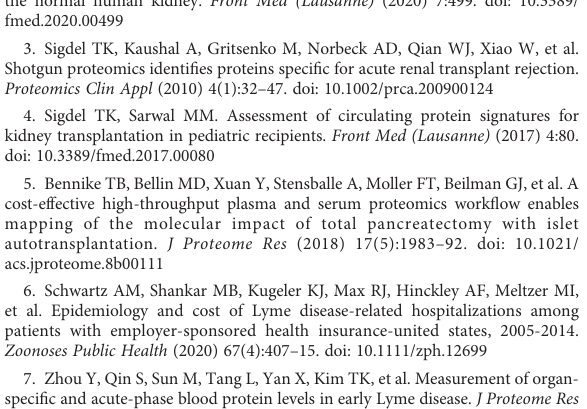
SUPPLEMENTARY FIGURE 1 Proteome comparison in localized and disseminated LD participants over time. (A) Analysis of differentially expressed proteins (DEPs) and immunoglobulins (DEIgs) between the localized (orange) and the disseminated (blue) LD samples at M0 (A) , M1 (B) and M3 (C) time points. For each cluster, the protein names were exported into the STRING interaction network. The white dotted lines represent the median of the Log2 difference of all proteins in the cluster. The proteins highlighted in red are involved in the acute phase response, in blue the proteins involved in the complement cascade, in green the proteins involved in the negative regulation of proteolysis, in yellow the proteins involved in the protein activation cascade, and in pink the proteins involved in the blood coagulation. (B-D) . Longitudinal analysis using the STEM program for clustering of the averaged protein intensity pro fi les across the 3 time points for the disseminated LD group and applying the protein cluster to the localized LD